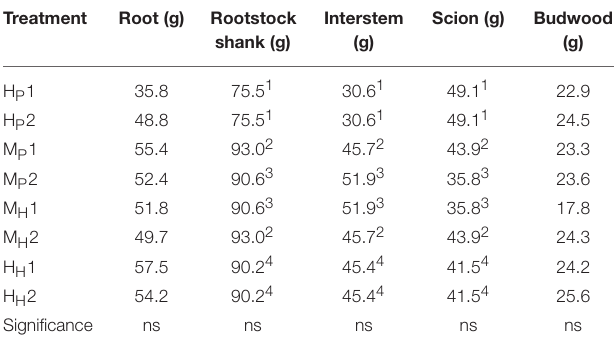
TABLE 5 | Summary of the final dry weight of roots, rootstock shank, interstem, scion, and budwood parts of bi-axis pear trees, considering the interaction between plant type (Homogeneous, H, Mixed, M), genotype (‘Hosui,’ H , ‘PremP009,’ P ) and shoot position (1, lower primary axis; 2, upper primary